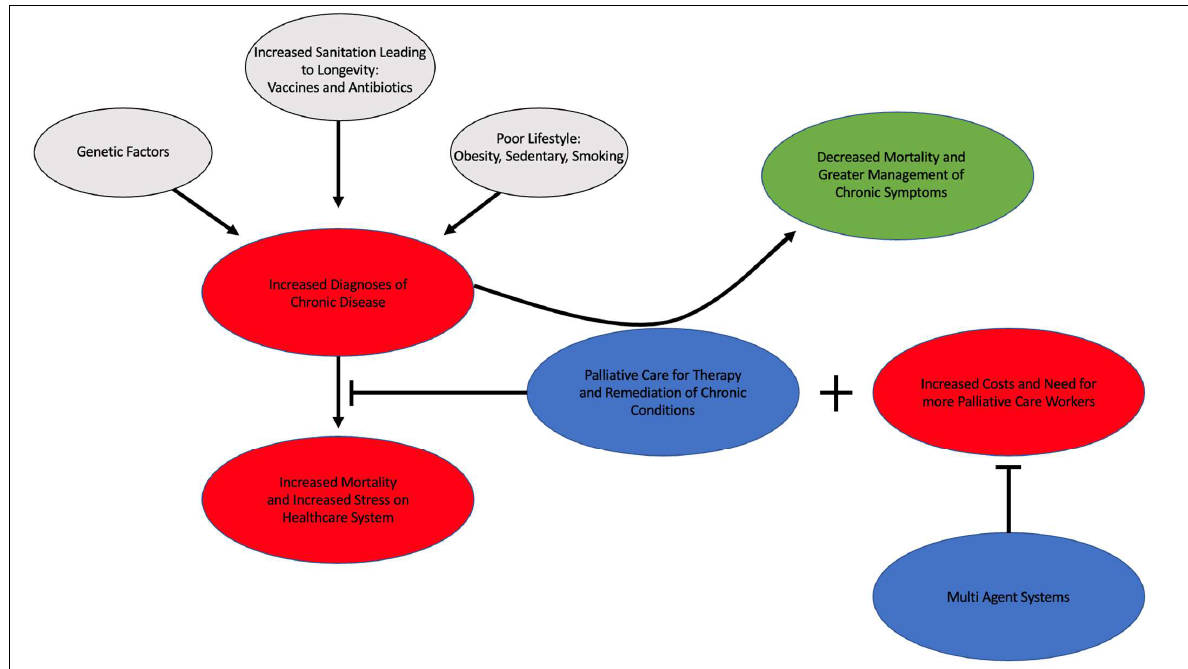
Figure 1. The increased prevalence of chronic disease from factors that contribute to greater longevity via vaccination and antibiotics, poor lifestyle, and genetic factors leads to increased mortality and stress on the healthcare system. The use of palliative care to treat and remediate chronic